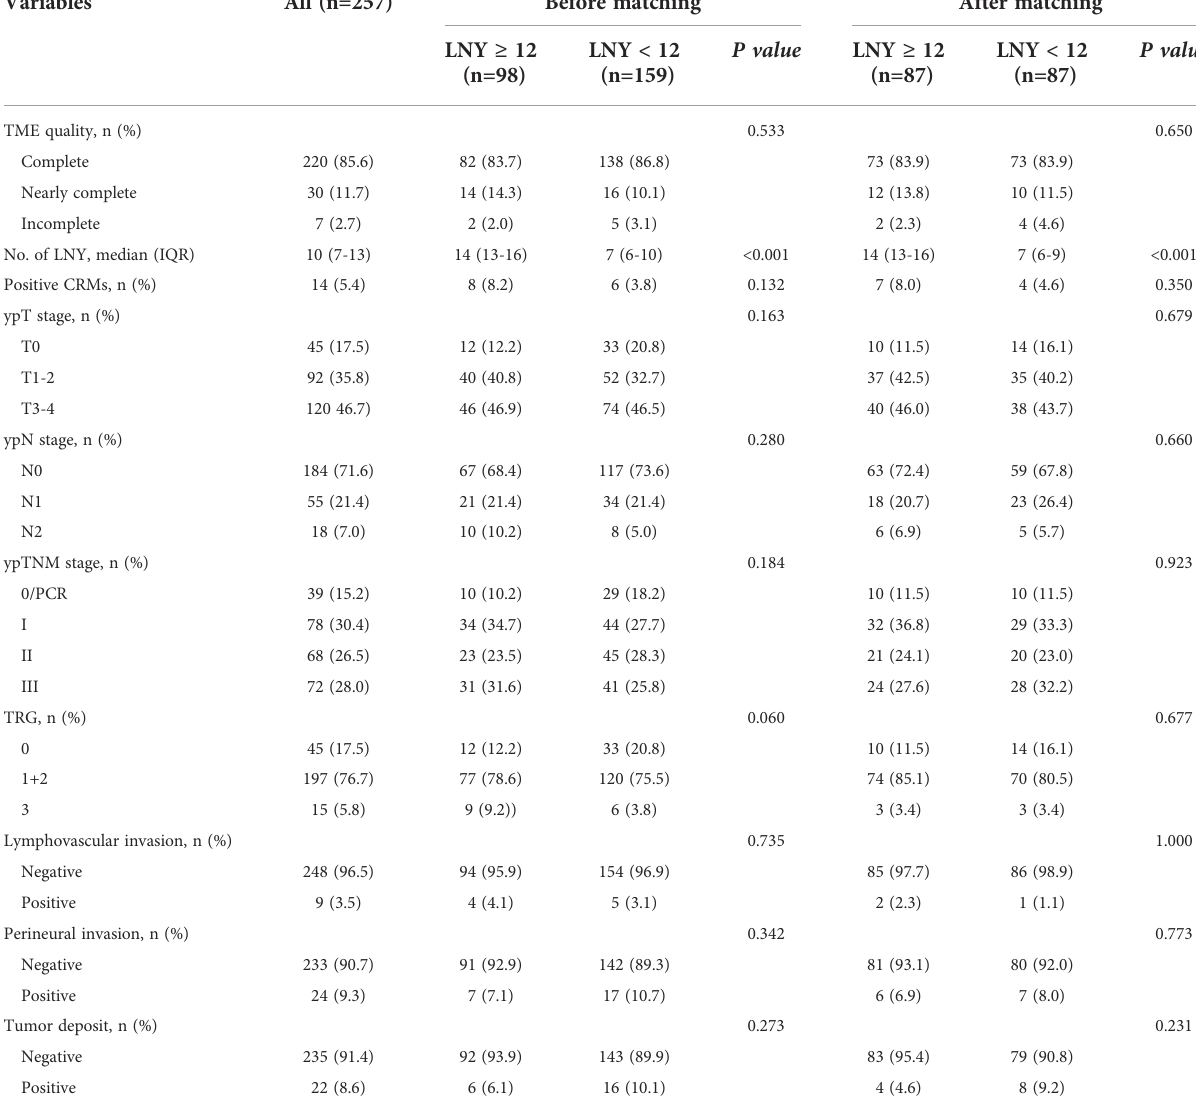
TABLE 2 Comparison of pathologic outcomes between LNY ≥ 12 group and < 12 group.